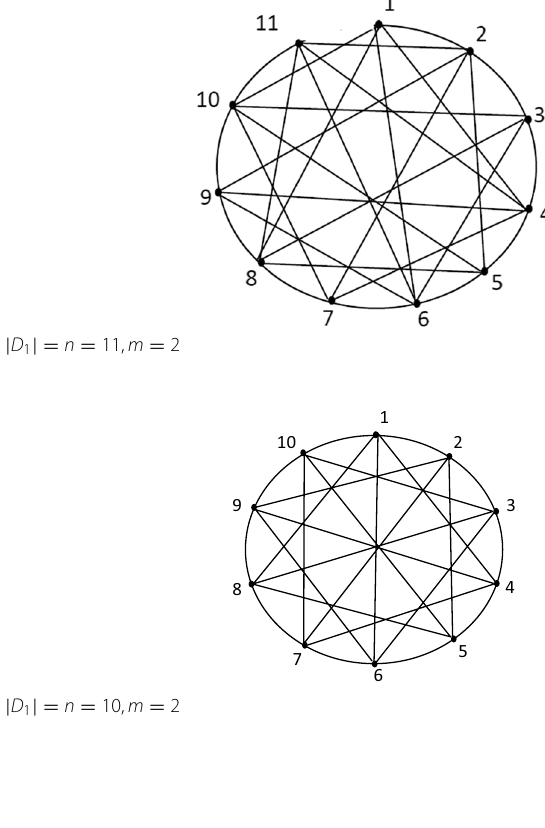
Fig. 11 | D 1 | = n = 10, m =